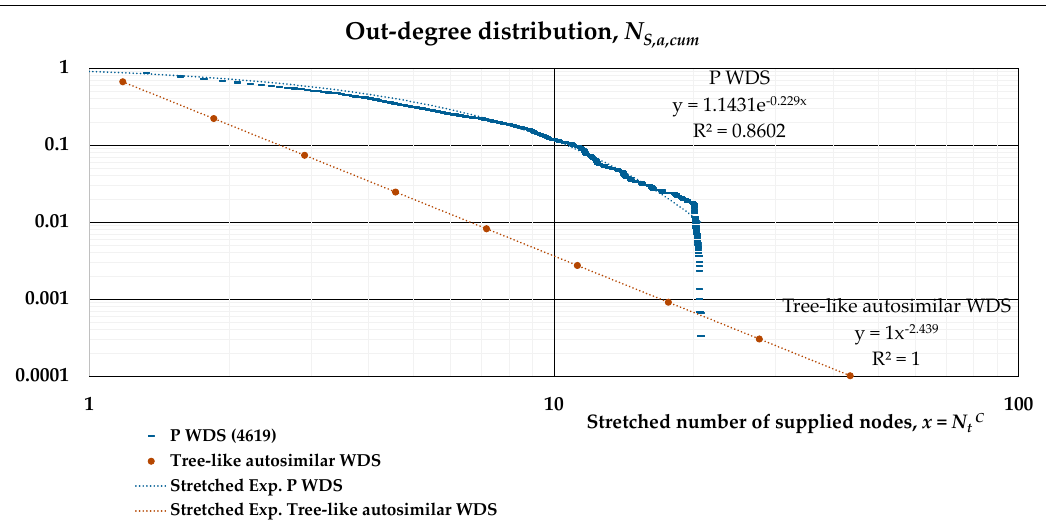
Figure 6. Cumulative out-degree distribution functions for U WDS, with stretched exponential fitting.